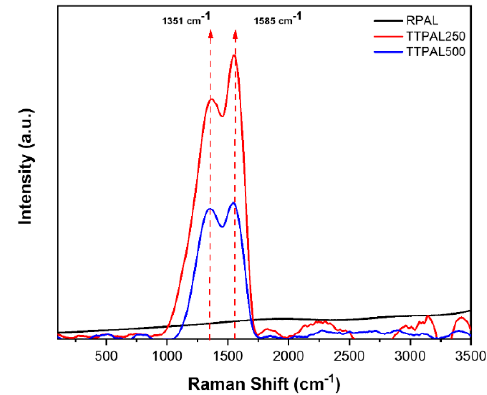
Figure 6. Raman spectra of the raw pineapple leaves (RPAL) and the thermally treated samples (TTPAL250 and TTPAL500).